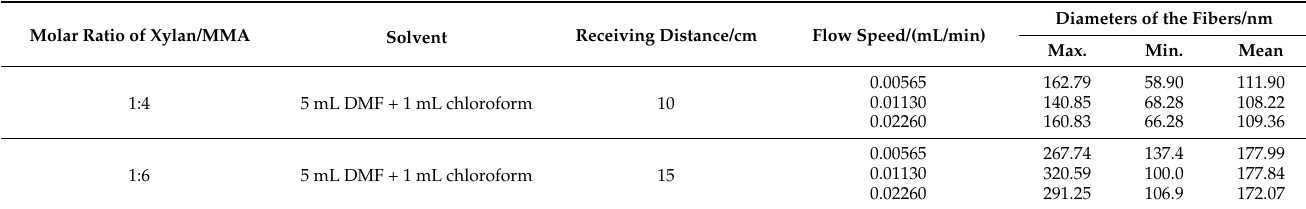
Table 3. The effect of flow speed on diameters of the fibers.